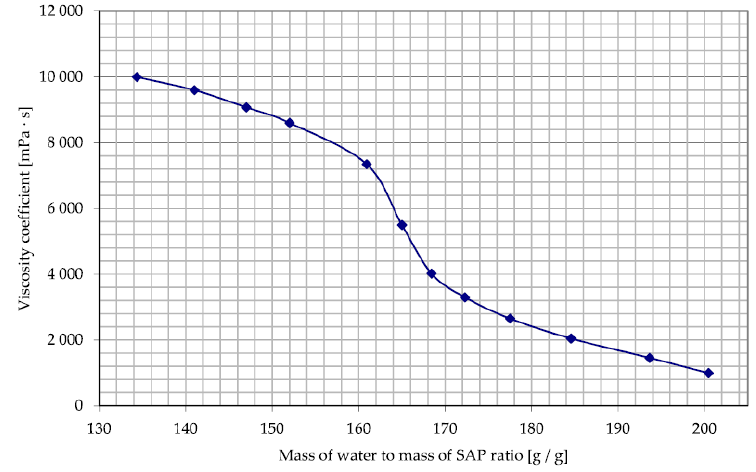
Figure 6. Chart showing the change in dynamic viscosity of the tap water mixture with superabsorbent polymers (SAP) M depending on the mass of water to mass of SAP M ratio. polymers (SAP) M depending on the mass of water to mass of SAP M